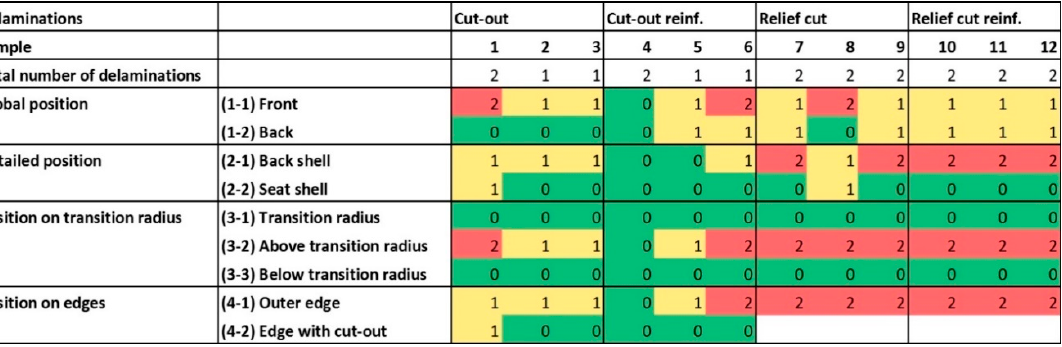
Figure 7. Heat map of delamination number and position in the 3D-molded plywood samples after forming.